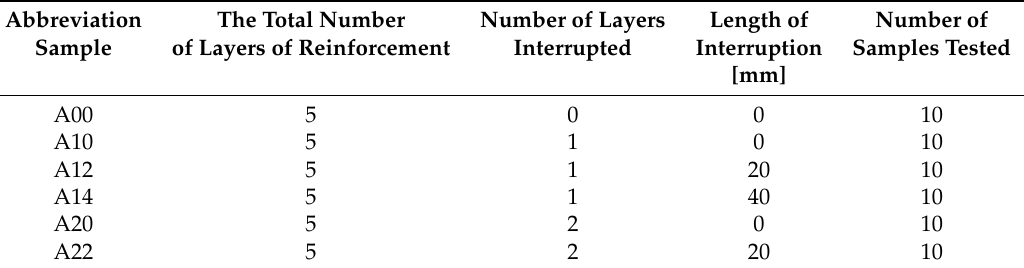
Table 1. Details about the manufactured